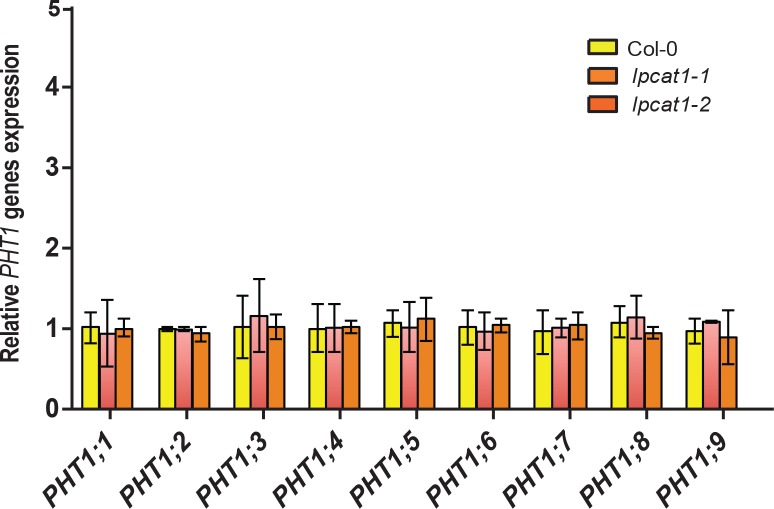
Relative expression level of all members of the Arabidopsis PHT1 gene family.Arabidopsis thaliana Col-0, lpcat1-1 and lpcat1-2 mutant lines were grown in agar medium supplemented with zinc (+Zn) for 18 days under long day conditions. mRNA level was quantified by RT-qPCR and normalized to the Ubiquitin10 reference mRNA level (UBQ10: At4g05320) and expressed as relative values against the UBQ10 normalized mRNA level in Col-0. Values are means of six biological replicates. Individual measurements were obtained from the analysis of shoots collected from a pool of 20 plants. Error bars indicate SD; one and two asterisk indicates a significant difference with Col-0 plants (ANOVA and Tukey test) of p<0.05 and p<0.01 respectively.